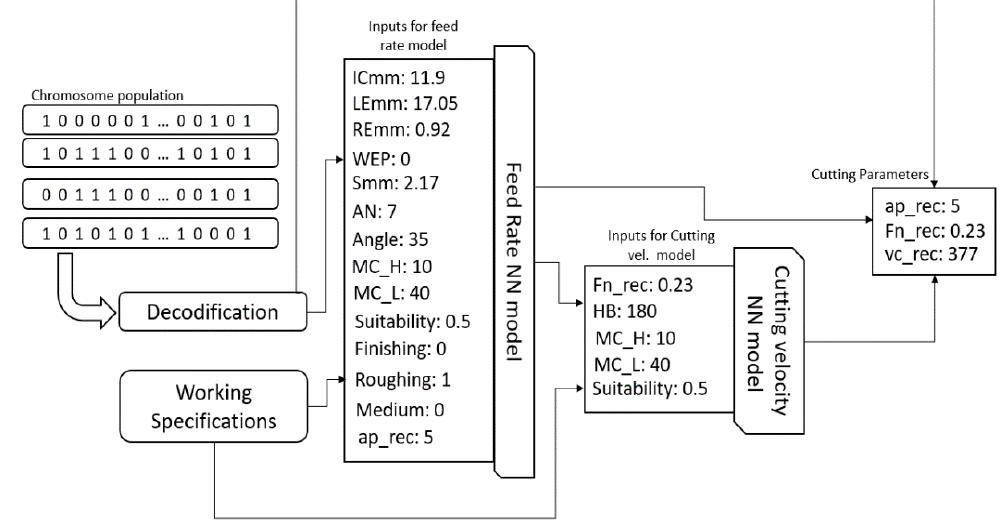
Figure 11. Neural network models in GA optimization.